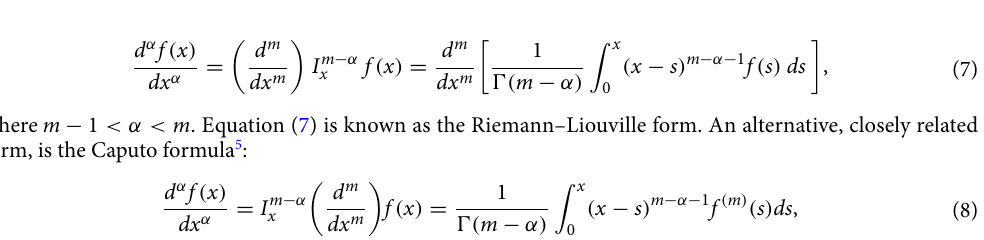
Figure 1. Nonlinear anisotropic fractional dimer where the excitation is on site 1 initially ( t σ 2 i σ case, σ 1 = − =